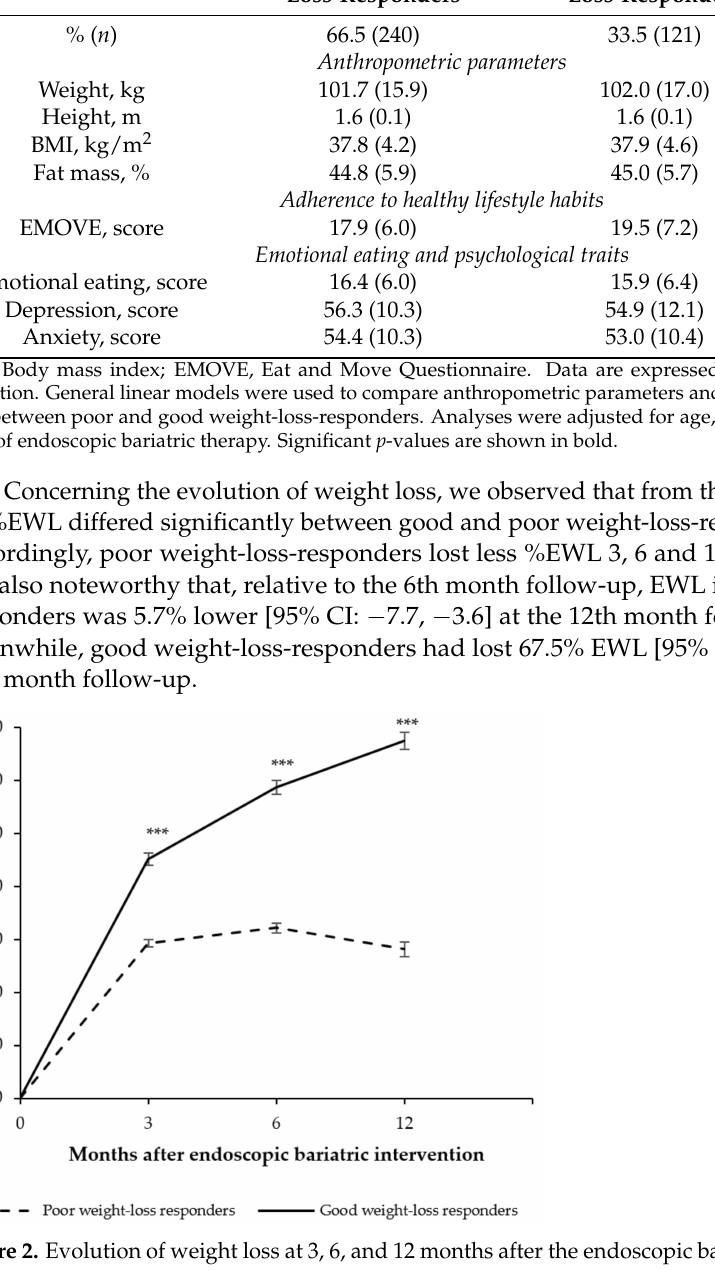
Table 1. Baseline differences in anthropometric parameters, adherence to healthy lifestyle habits, emotional eating, and psychological traits between poor and good weight-loss-responders. Poor Weight